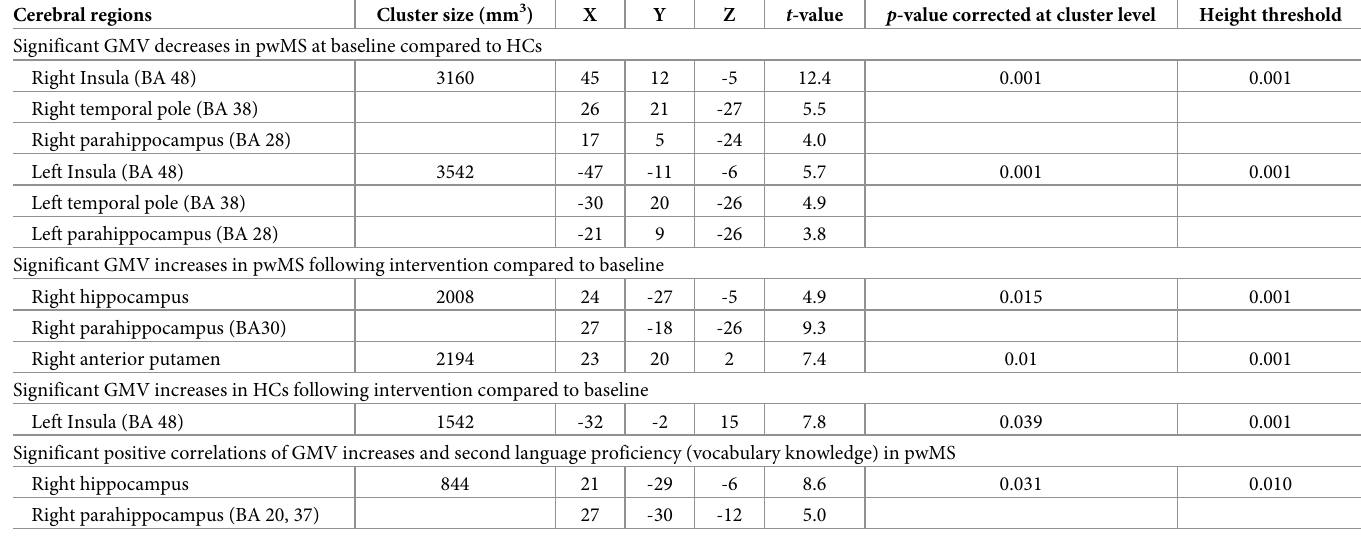
Table 4. Statistical parametric mapping findings showing the locations of significant changes of whole brain grey matter volume (VBM) following intervention; and correlation of increases in GMV with improvement in second language proficiency (vocabulary knowledge) in people with multiple sclerosis (pwMS) and healthy control subjects